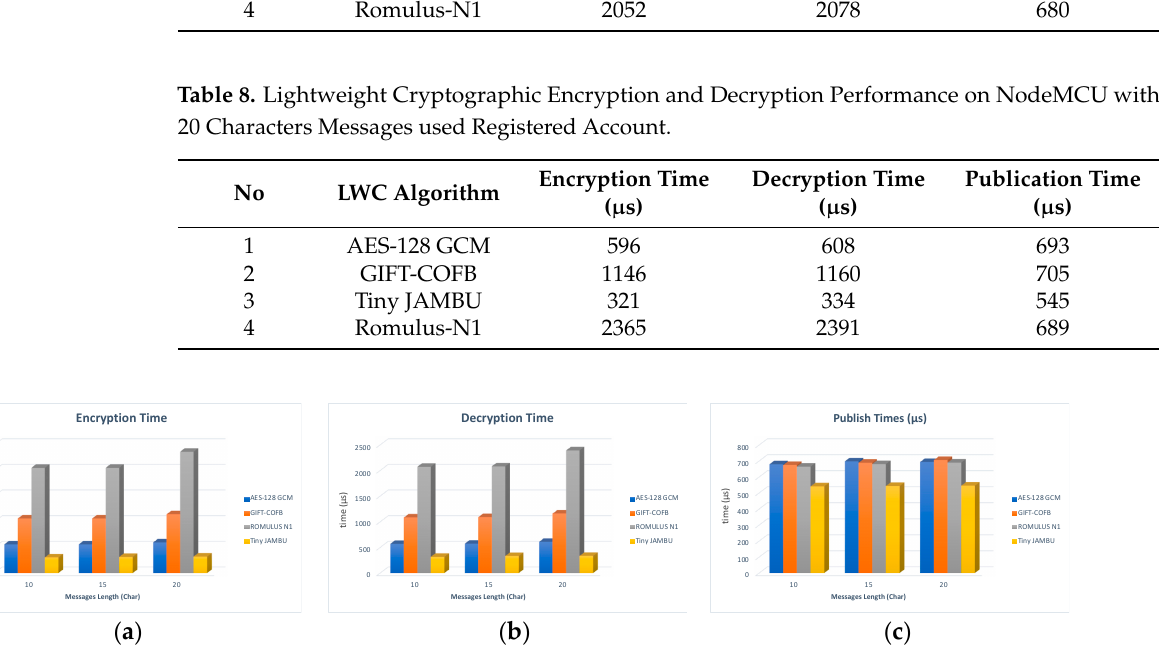
Table 6. Lightweight Cryptographic Encryption and Decryption Performance on NodeMCU with 10 Characters Messages used Registered Account.